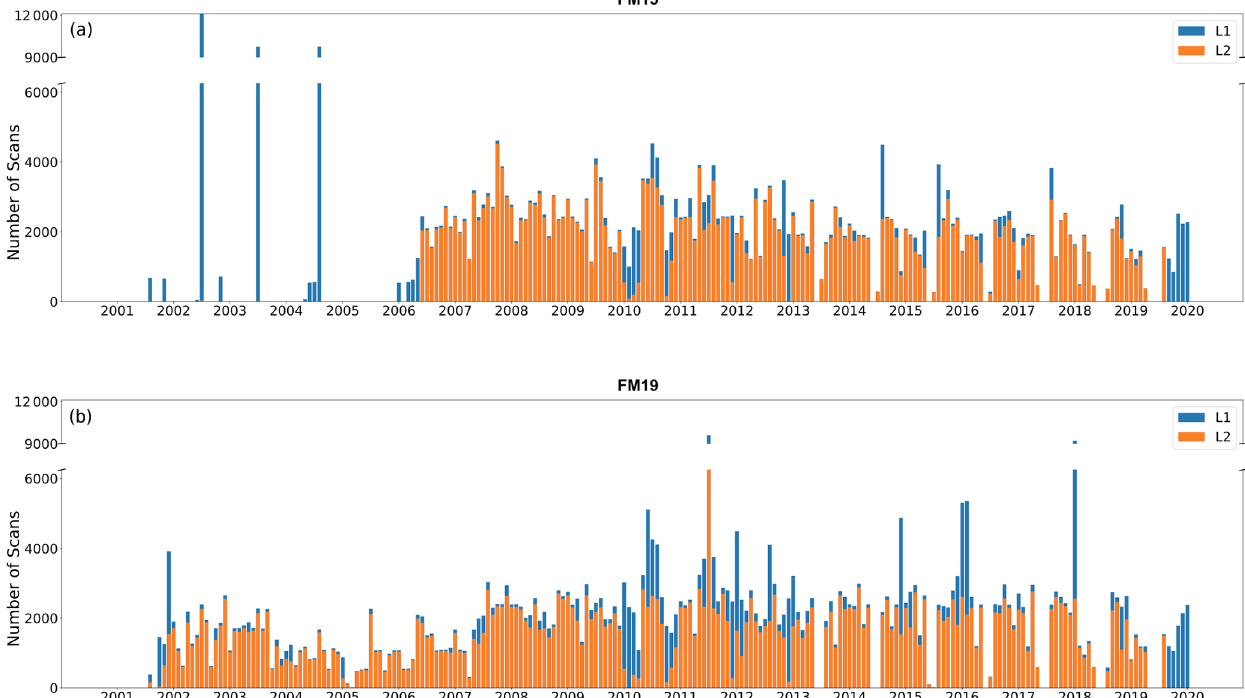
Figure 3. Number of L1 and L2 scans by month for FM13 (a) and FM19 (b) . The ticks on the x axis correspond to 1 January for each